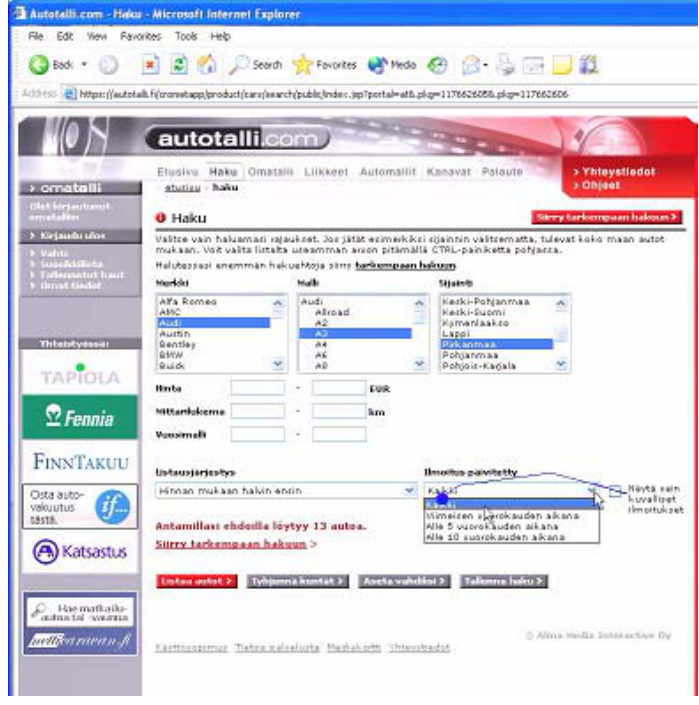
Figure. 2. The main search page with an overlay of the gaze path indicating a problematic